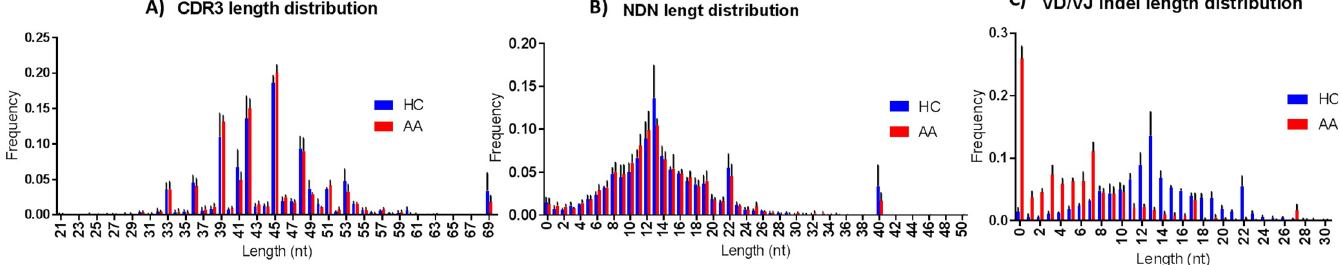
Fig 6. CDR3 bulk characteristics in Treg of patients and healthy controls. A) . nucleotide length of CDR3 segment B) . NDN nucleotides size C) . V-D and D-J insert size. NDN and CDR3 length in cases and controls showed same distribution for Treg and total